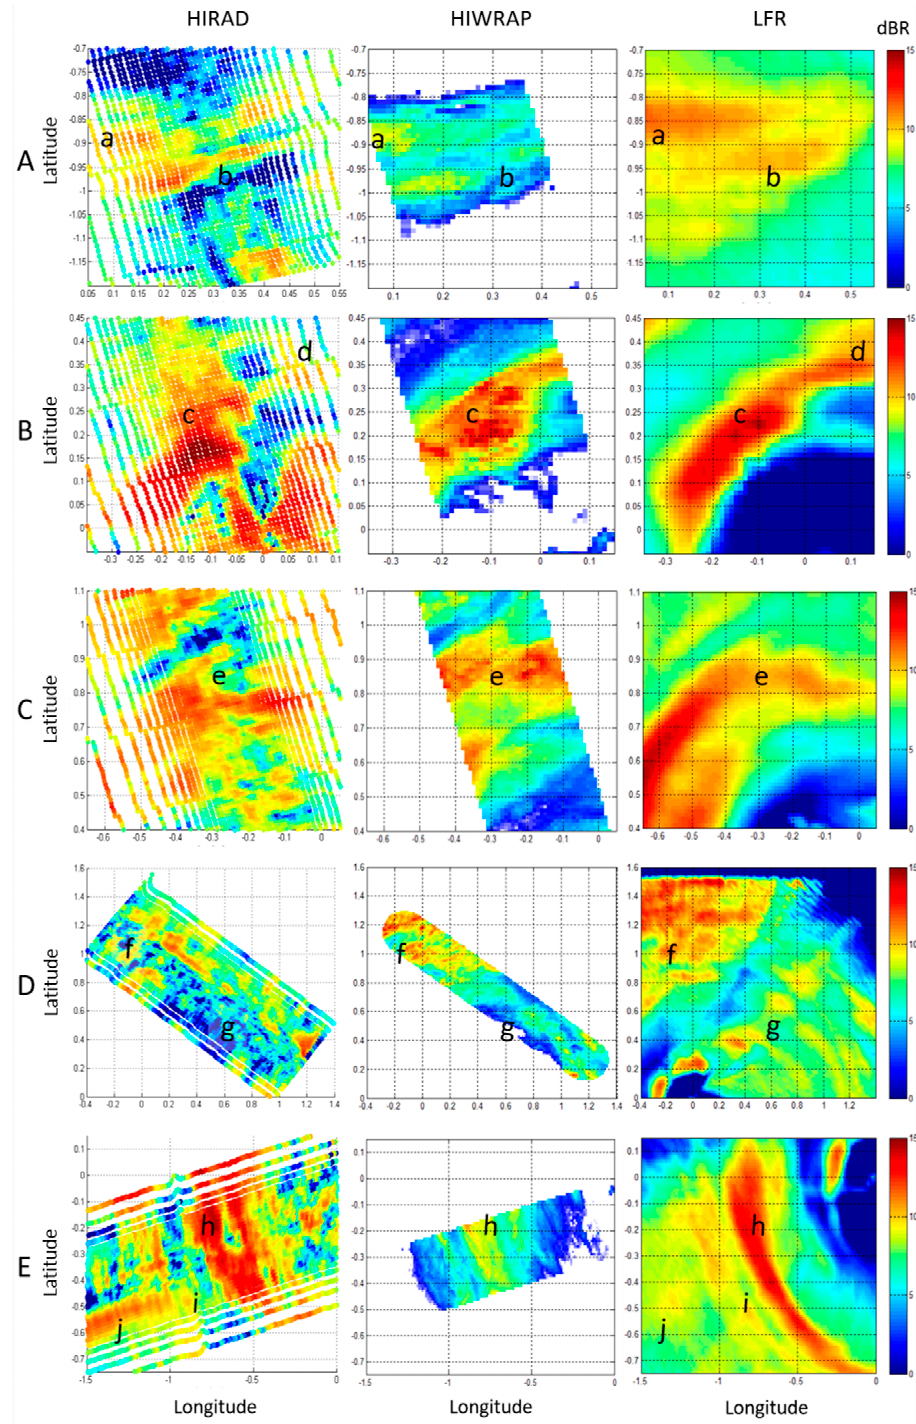
Figure 19. HIRAD, HIWRAP and LFR rain rates (dBR) in the selected regions ( A – E ), where rows are the regions, and columns the instruments. Rain features of interest are marked by letters a–j. LFR row ( E ) uses the nearest measurement available, which is − 0.4 h displaced.